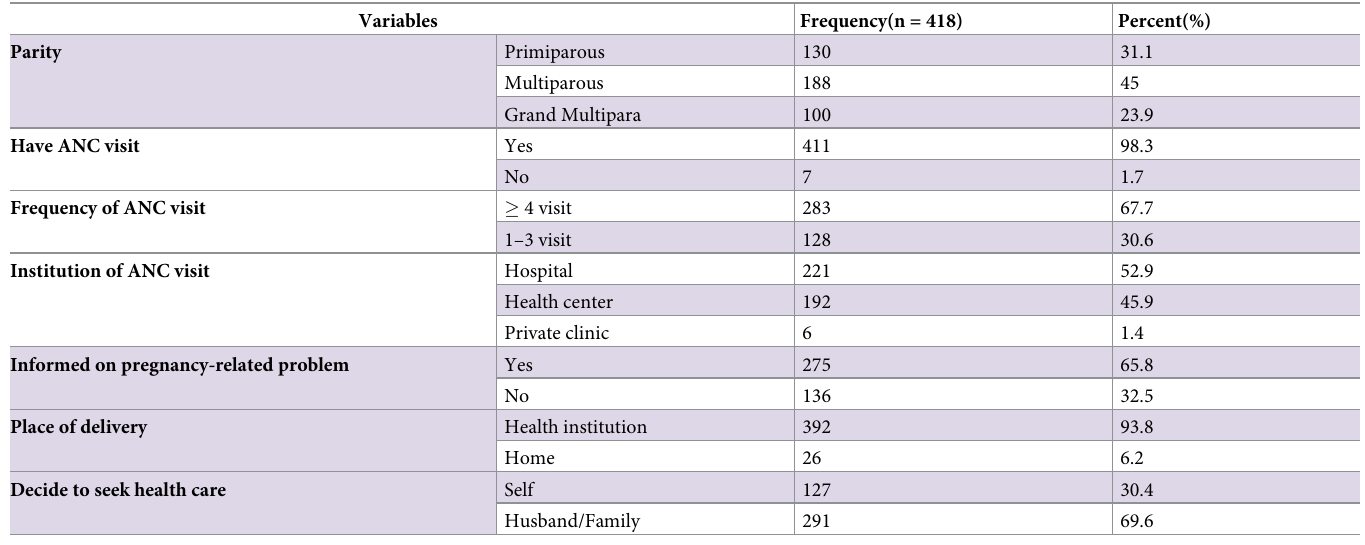
Table 2. Obstetric characteristics and health service utilization of the respondents in Arba Minch town, Southern Ethiopia, December